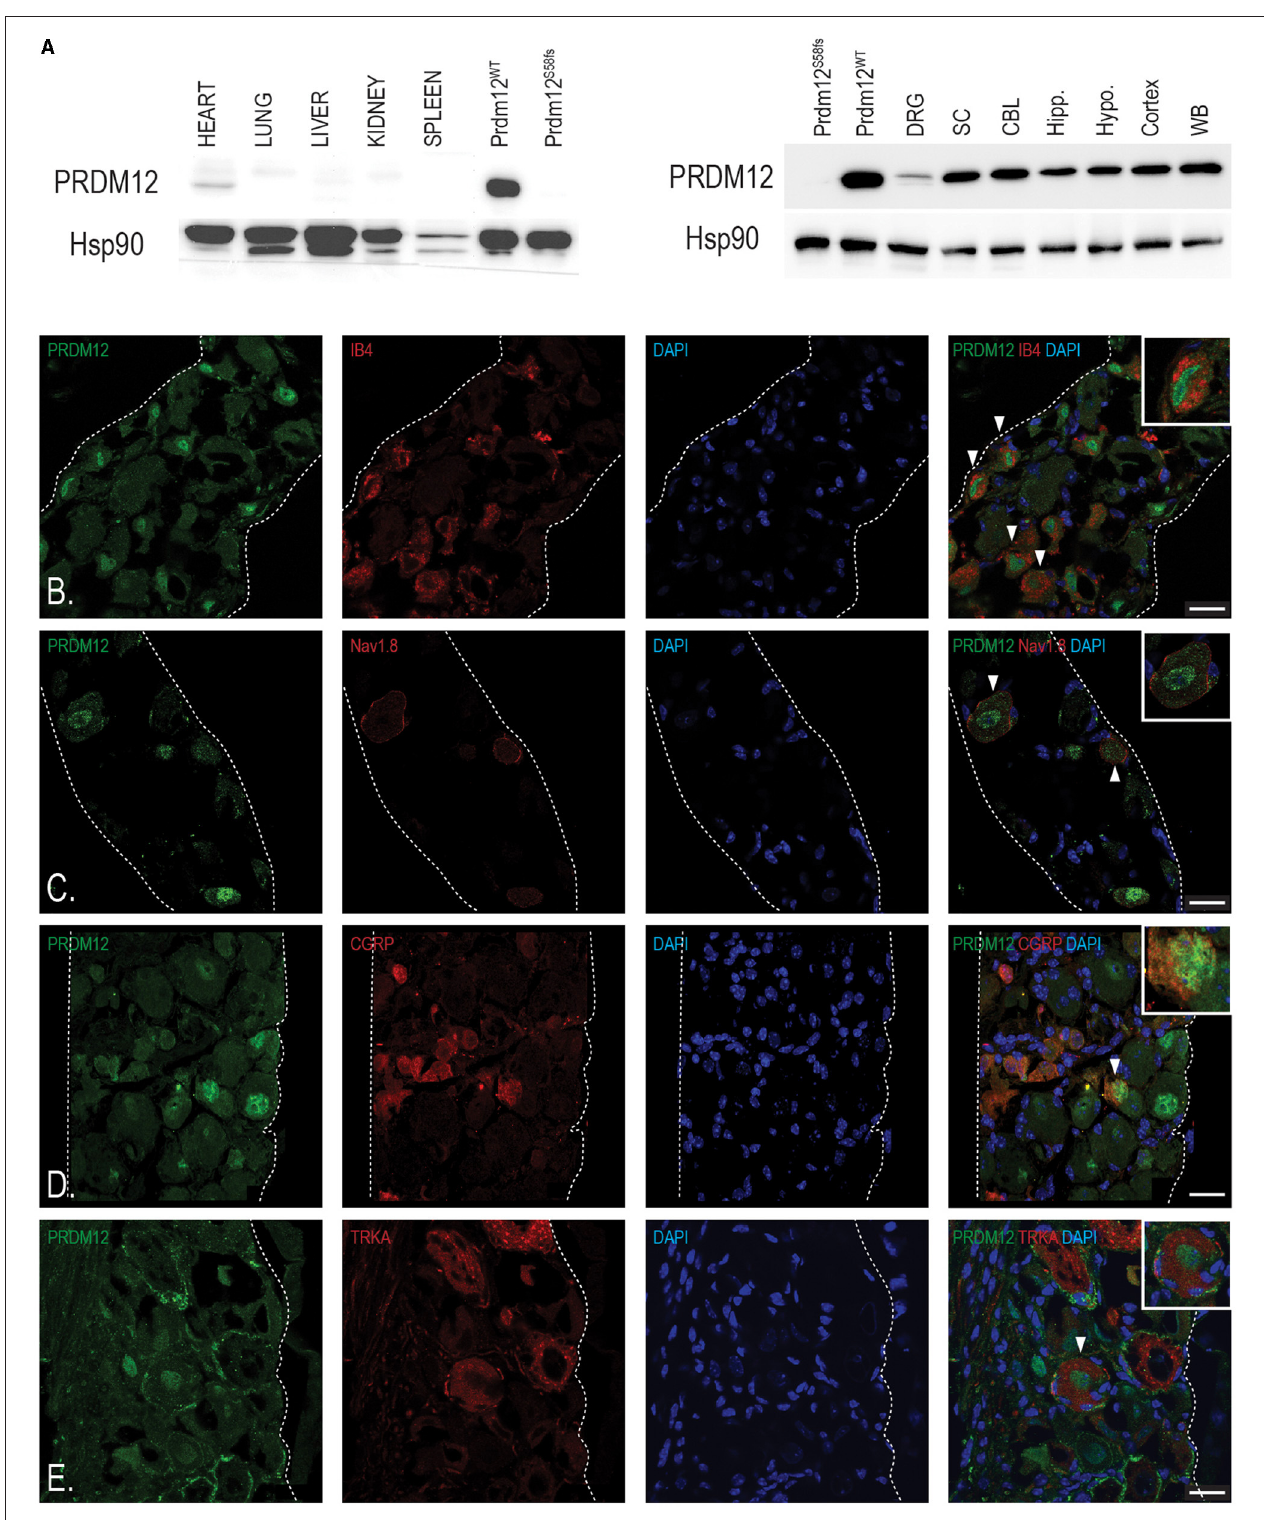
FIGURE 2 | Tissue analyses reveal PRDM12 expression in adult mouse peripheral and central nervous tissue. (A) Upper panel, western blot analysis shows a slight PRDM12 protein expression in adult heart tissue, but no detectable expression in the lungs, livers, kidneys, or spleen. Lower panel, western blot indicates PRDM12 protein level expression in the central nervous system (CNS): whole brain (WB), cortex, hypothalamus (Hypo.), hippocampus (Hipp.), cerebellum (CBL), and spinal cord